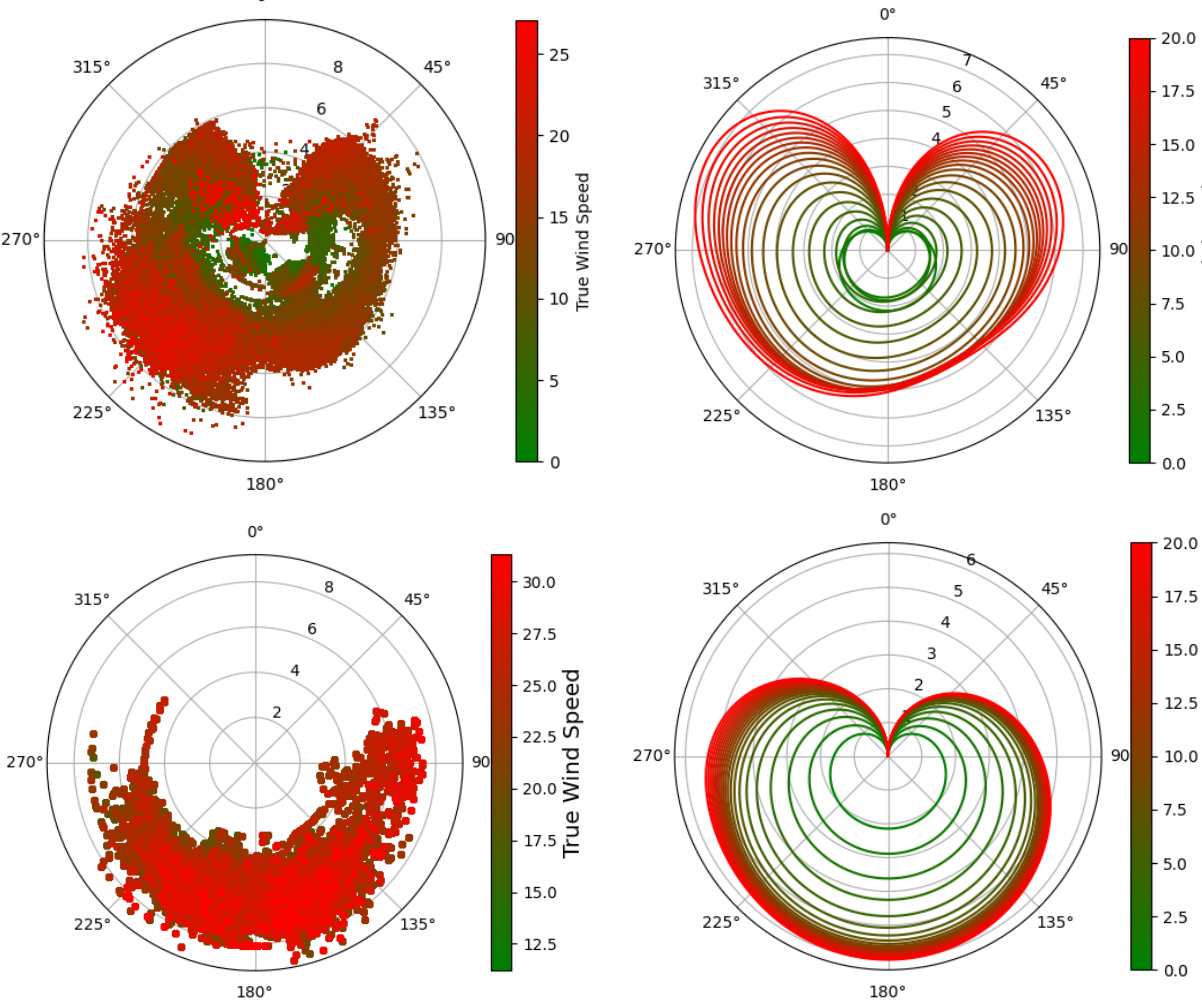
Figure 13. Collected data ( left ) and resulting PolarDiagramCurve ( right ) for full sails (first row) or for foresail only (second